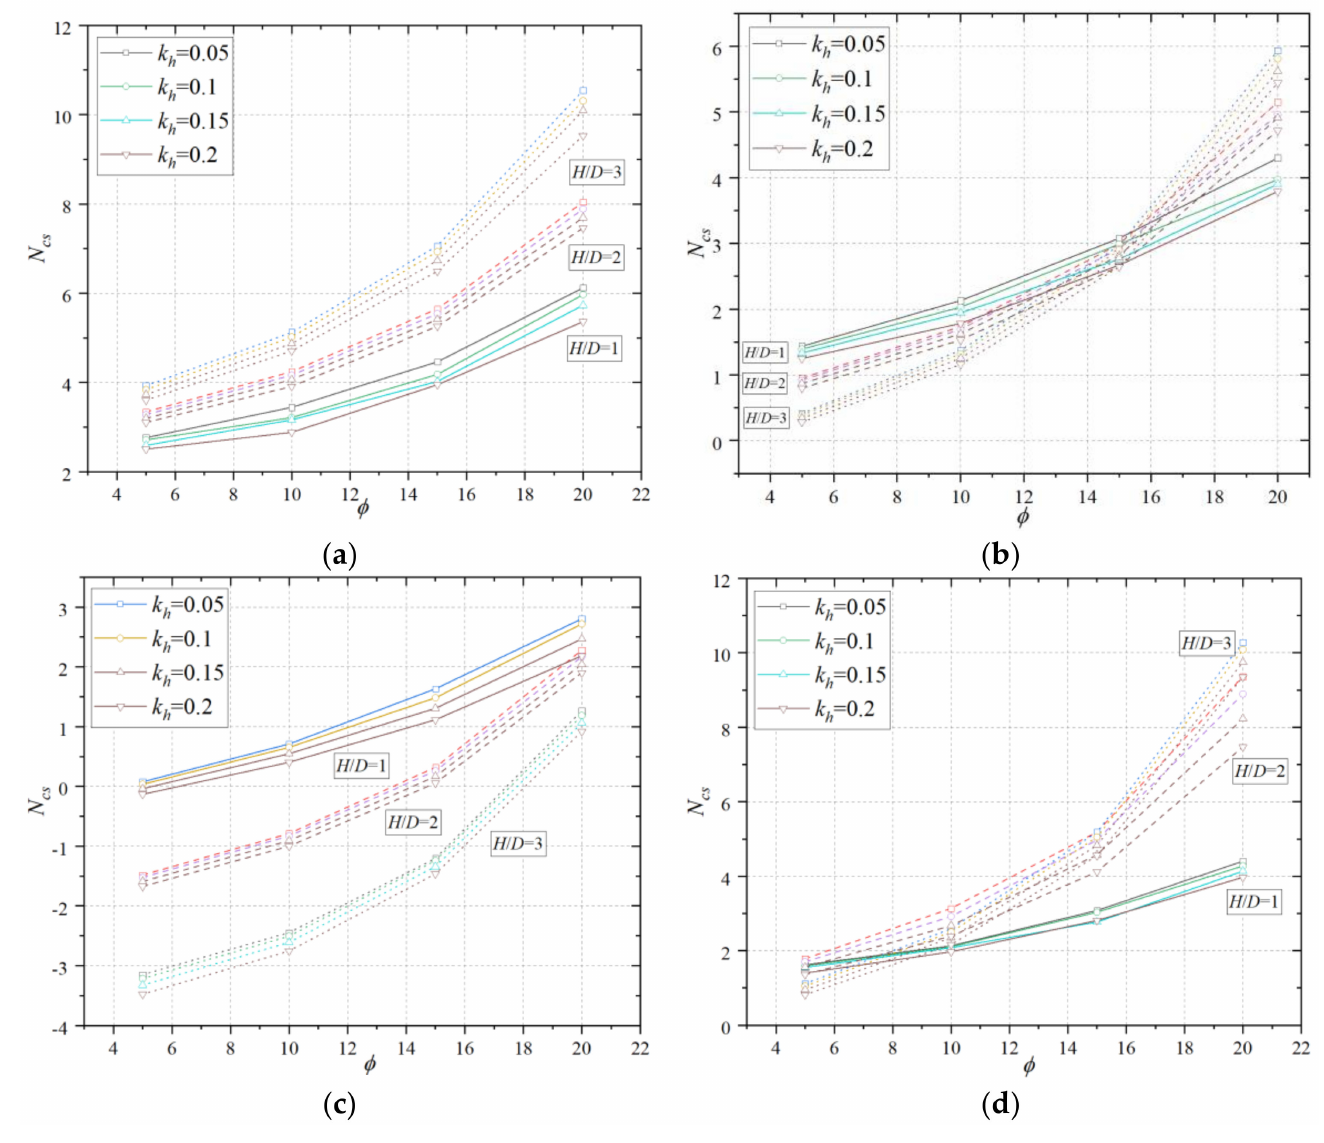
Figure 7. N cs - ϕ curves with different H / D and k h for ( a ) γ D / c = 0, S / D = 3; ( b ) γ D / c = 1, S / D = 3; ( c ) γ D / c = 1, S / D = 1.5; and ( d ) γ D / c = 1, S / D =